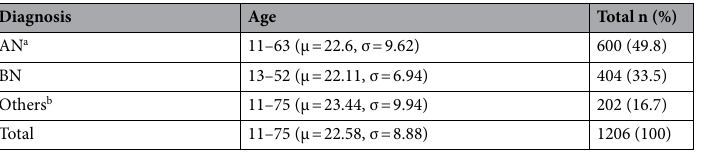
Table 1. Demographic characteristics of patients, grouped by ED diagnoses. All patients were female. AN, Anorexia Nervosa; AN-R, AN-Restrictive type; AN-BP, AN-Binge Purging type; BN, Bulimia Nervosa; BED, Binge Eating Disorder; ARFID, Avoidant Restrictive Food Intake Disorder; OSFED, Other Specified Feeding or Eating Disorder; UFED, Unspecified Feeding or Eating Disorder. a AN = AN-R + AN-BP. b Others = BED + ARFID + OSFED +